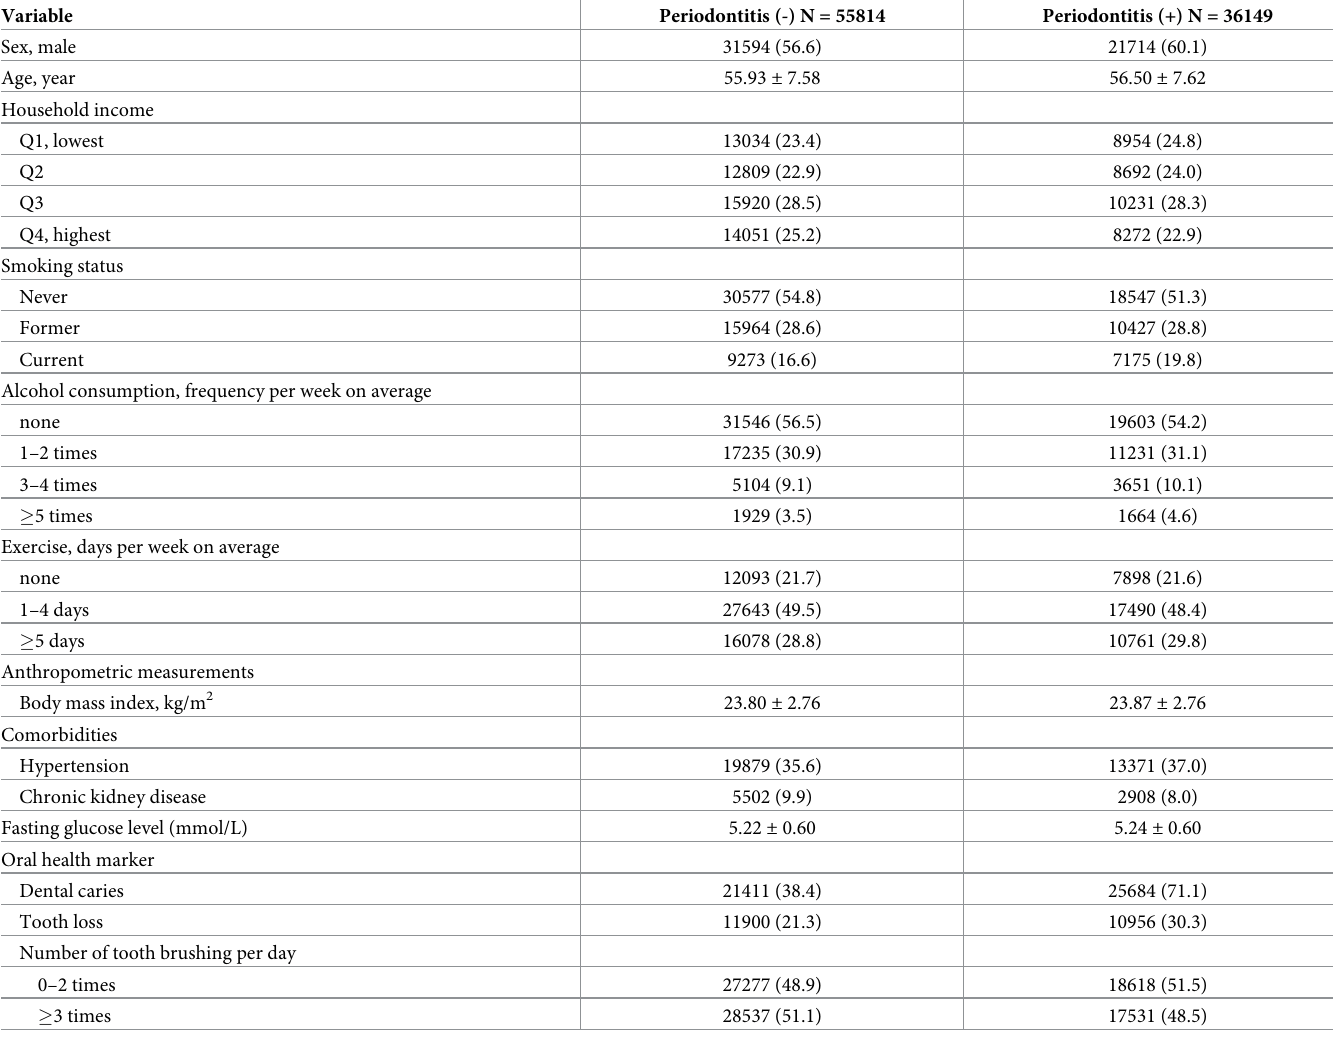
Table 2. Clinical characteristics of the study participants according to the presence of